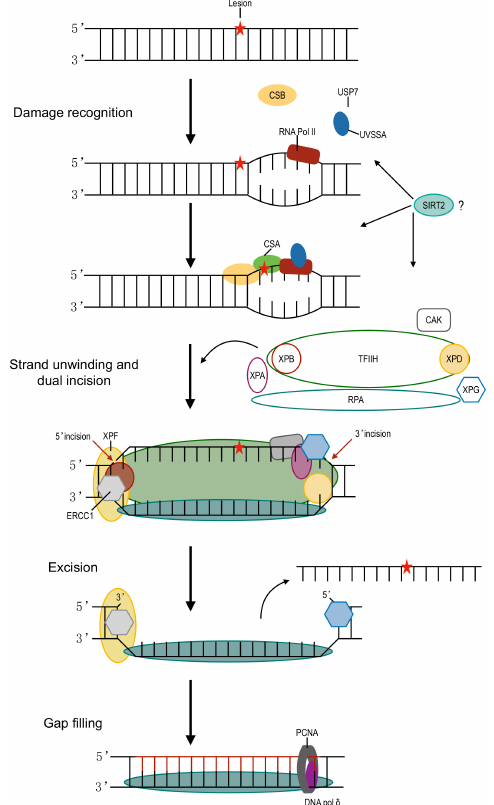
Figure 1. Schematic representation of transcription-coupled nucleotide excision repair. The DNA lesion, as indicated by the red star, stalls transcription by RNA polymerase II (RNA pol II). UVSSA and USP7 stabilize and form a complex with CSB. CSA binds to CSB, likely resulting in backward translocation of RNA pol II and allowing room for NER machinery. TFIIH binds XPG, a structure- specific endonuclease. The multiprotein complex unwinds DNA surrounding the lesion through helicase activity. XPD and XPA act to verify the presence of chemically modified nucleotides in the site of damage. XPF-ERCC1 is directed to the damage by RPA and makes a 5 (cid:48) incision while XPG is responsible for the 3 (cid:48) incision. PCNA is loaded onto XPF-ERCC1 and recruits DNA pol δ to fill the gap. SIRT2 promotes TC-NER in DRG, although the exact mechanism is not yet